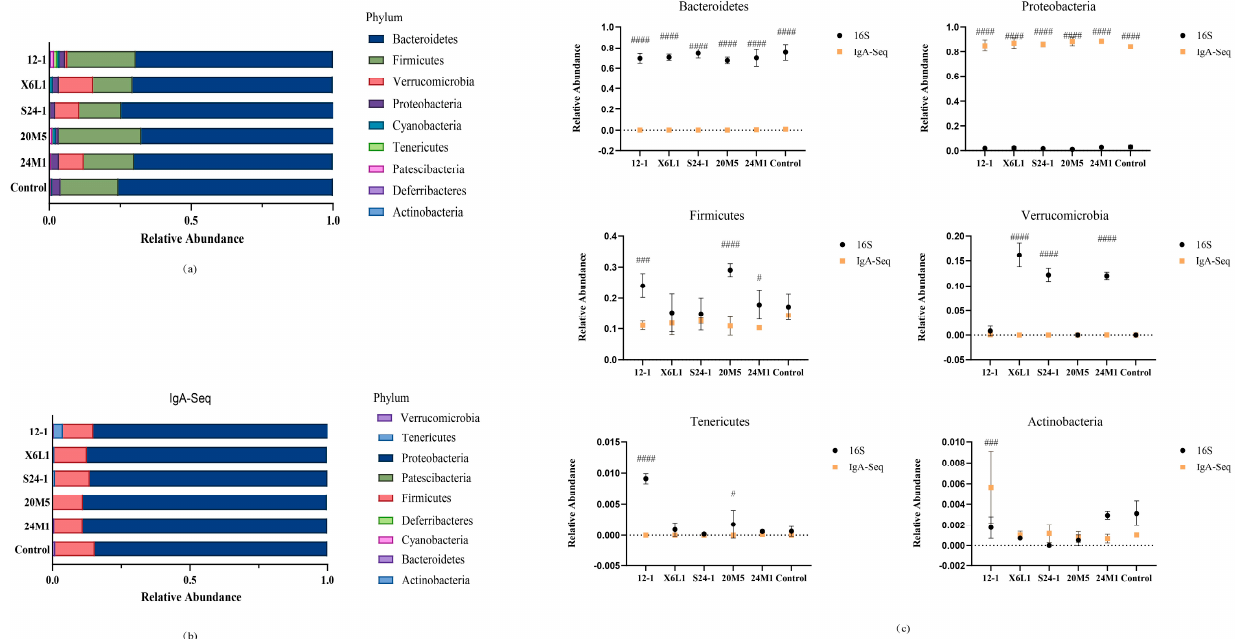
Figure 4. Effect of L. fermentum on gut microbiota in mice at phylum level. ( a ) Mouse colon contents 16S rDNA sequencing, phylum level relative abundance; ( b ) Mouse colon contents IgA − coated bacteria 16S rDNA sequencing, phylum level relative abundance; ( c ) Results of comparison between IgA − coated bacteria and colon contents microbiota on gate level (“#”indicates p < 0.05, “###” indicates p < 0.001, “####” indicates p < 0.0001 (compared with 16S)).